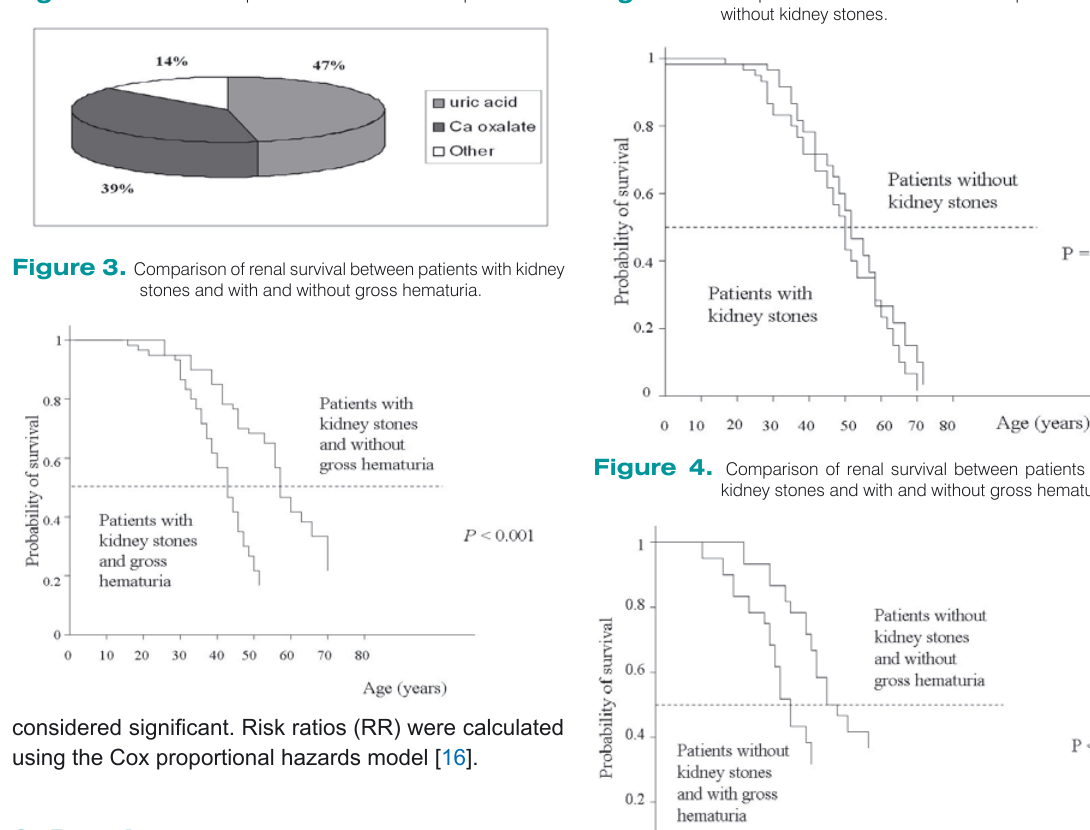
Figure 1. Chemical composition of stones in ADPKD patients. Figure 2. Comparison of renal survival between patients with and